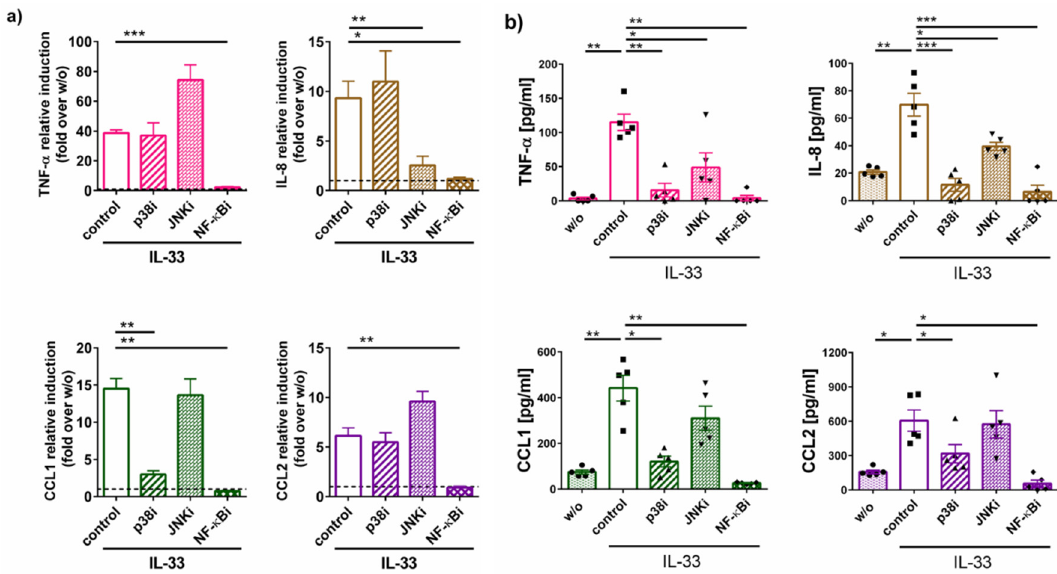
Figure 4. IL-33-induced transcription of cytokine genes chiefly relies on NF- κ B, while cytokine release requires p38 activity. ( a ) Cells were pre-treated with the according inhibitors for 15 min (or no inhibitor as control), then stimulated with IL-33 for 90 min. mRNA quantification was performed by RT-qPCR. ( b ) MCs were treated with IL-33 for 24 h when supernatants were collected. Cytokine proteins were quantified by ELISA. Each dot represents an independent MC preparation. Data are presented as mean of 5–7 experiments ± SEM. * p < 0.05, ** p < 0.01, *** p < 0.001, p38i = p38 inhibitor (SB203580), JNKi = JNK inhibitor (SP600125), NF- κ Bi = NF- κ B inhibitor (Bay11-7082), w/o = without IL-33 (negative control).